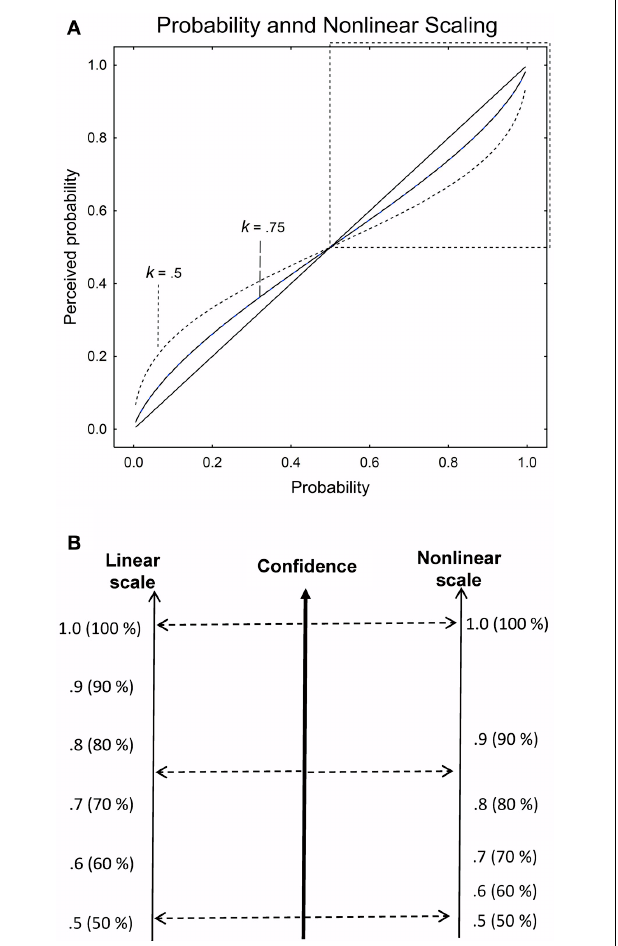
FIGURE 1 | (A) Linear and nonlinear perception of proportions (probability). The solid identity line represents a perfectly linear representation of proportion ( k = 1), whereas the non-linear functions are two examples of non-linear representations ( k = 0 . 75 and 0.5). The upper right region of the graph delineated by a square is the region of interest in half-range probability judgment. (B) Schematic example of the direct and proportional mapping from an internal confidence variable to a linear and a nonlinear perception of the confidence scale in a half-range